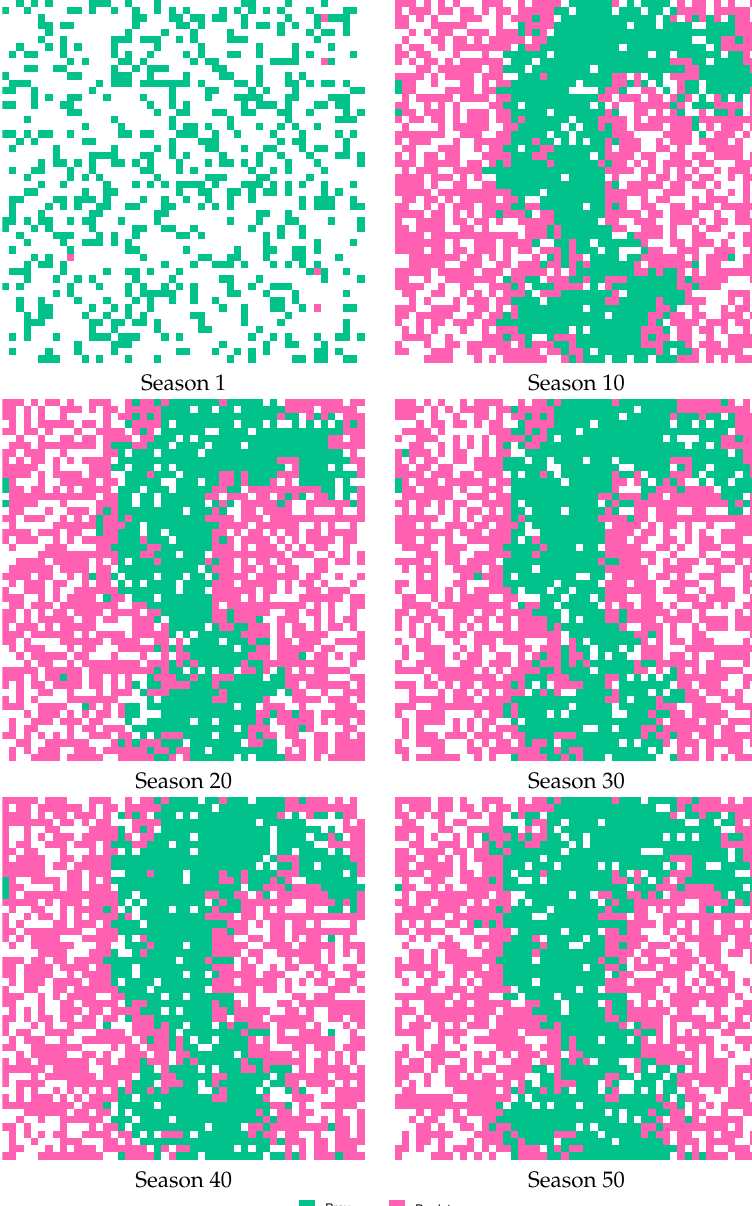
Figure 8. Population behavior without using